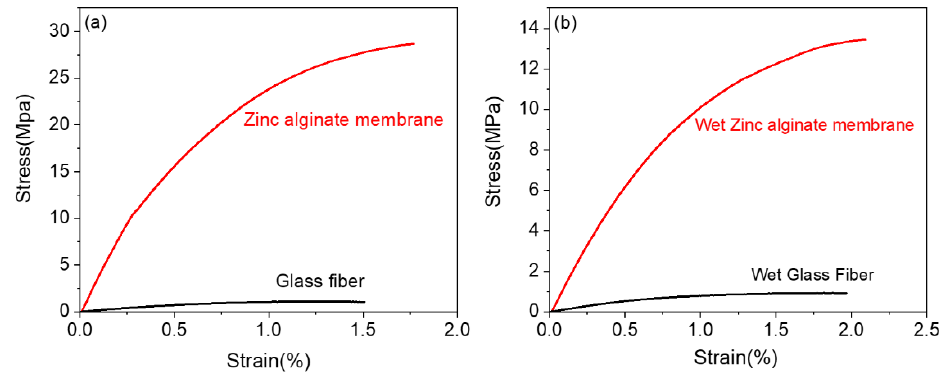
Figure 2. Stress–strain curves of the as-prepared ZA membrane and the glass-fiber separator ( a ) before and ( b ) after soaking in the ZnSO 4 electrolyte.